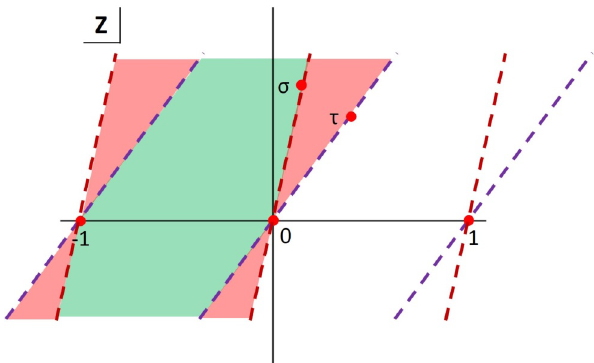
Figure 2 . The complex z plane. The shaded green domain represents the intersection of the (cid:0) − 1 (cid:1) (cid:0) z (cid:1) (cid:0) − 1 (cid:1) (cid:0) z (cid:1) domains Im > Im > 0 and Im > Im > 0 . The shaded red domains belong to one τ τ σ σ domain but not both. The green domain is referred to as D 0 in the main text. Integer shifts to the left and right for n > 0 are denoted by D n and D − n